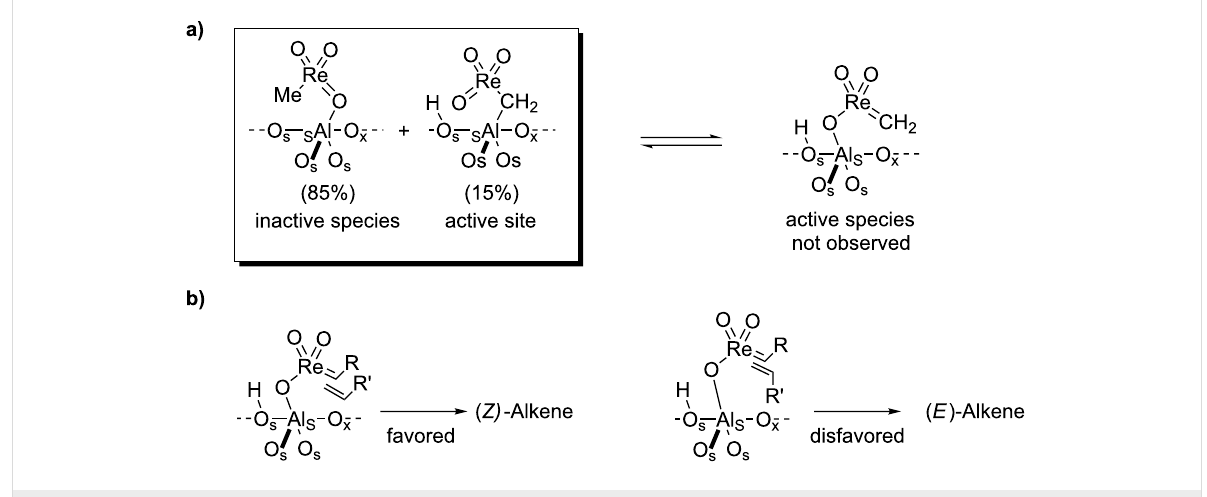
Re-based alumina supported